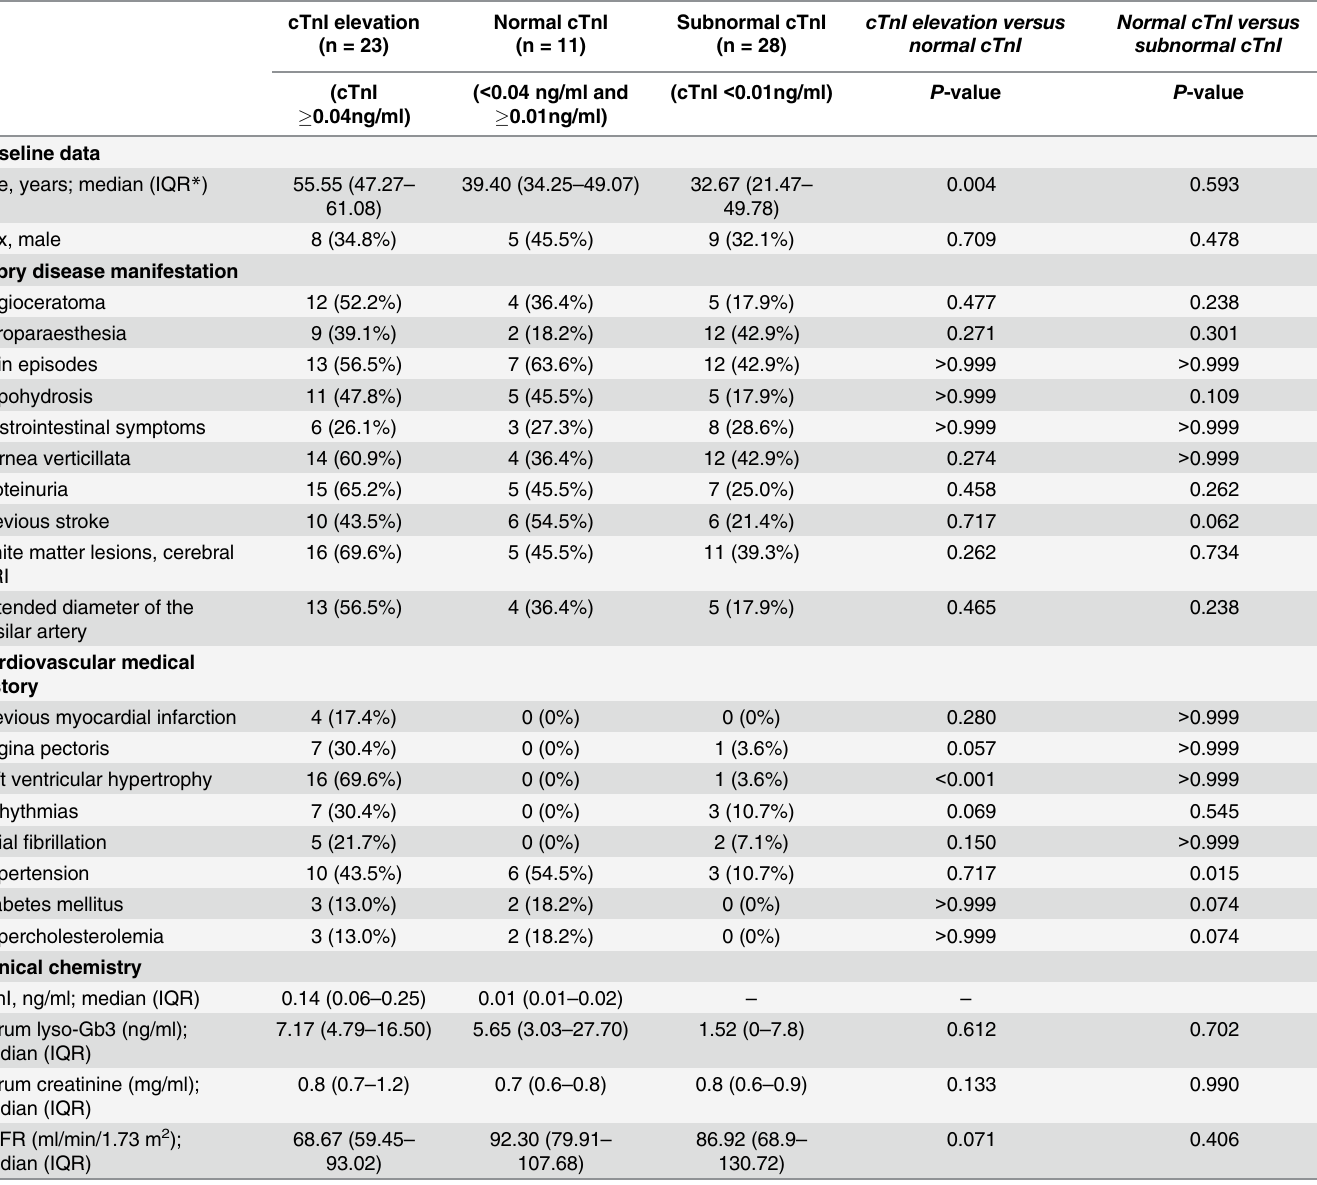
Table 3. Patients with Fabry disease dichotomized according to different categories of cTnI